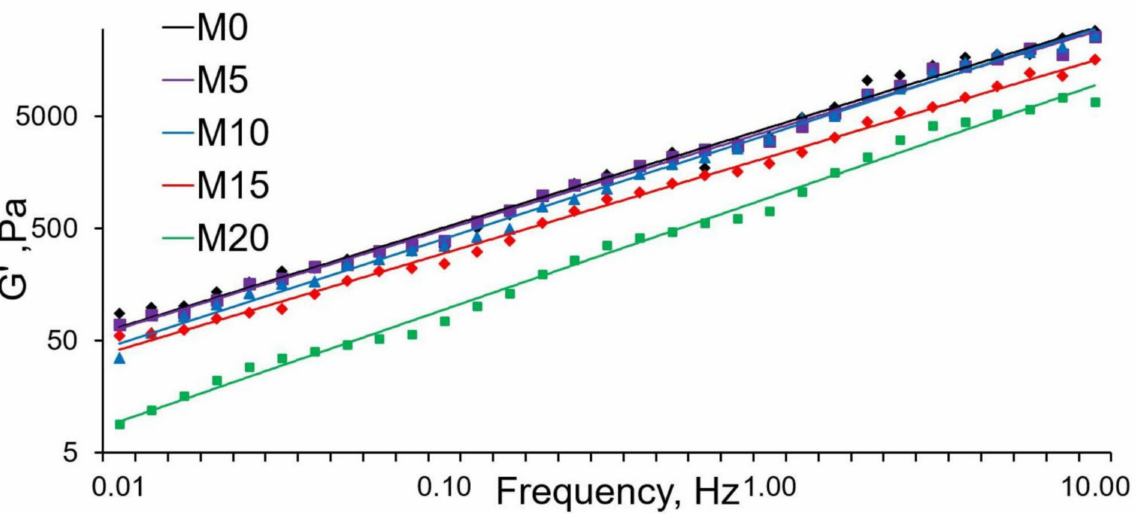
Figure 4. Correlation between G’ and frequency.